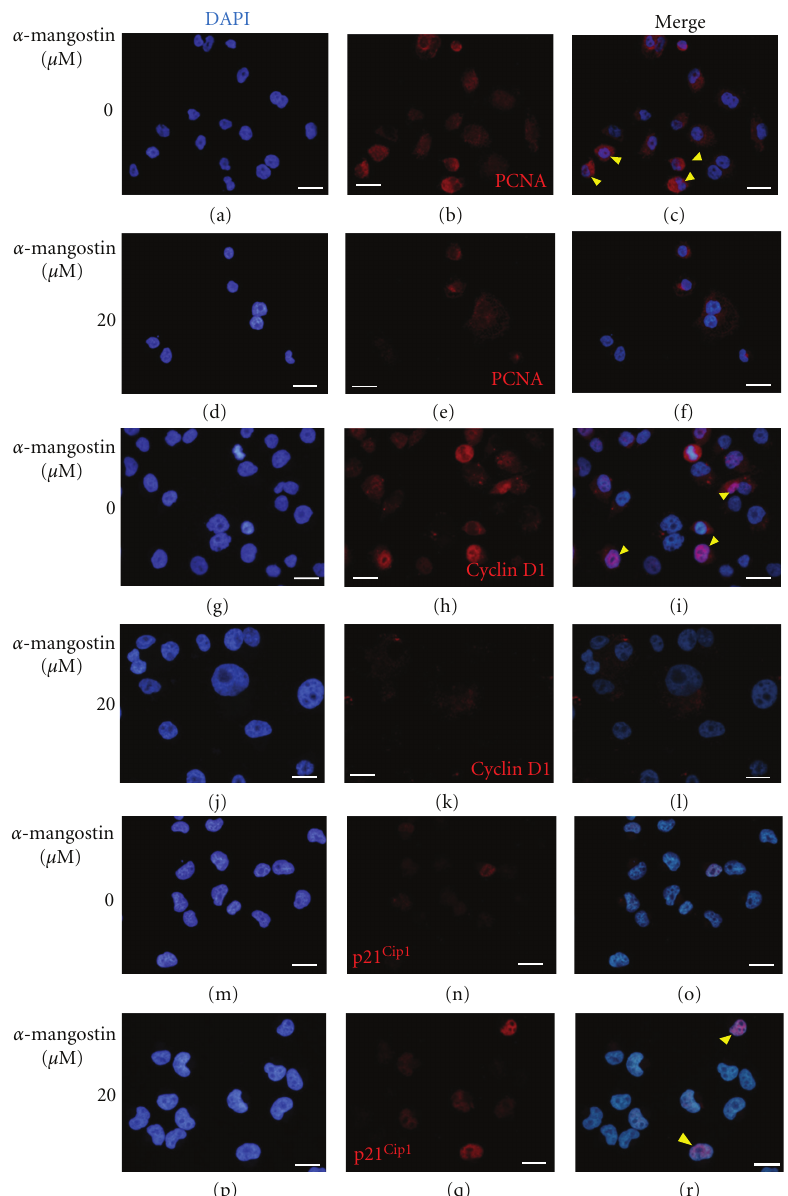
Figure 6: Expression of PCNA, cyclin D1 and p21 cip1 proteins after α -mangostin treatment. Immunofluorescence of PCNA (a)–(f), cyclin D1 (g)–(l), and p21 cip1 (m)–(r) in MDA-MB231 cells after 24 h of treatment with α -mangostin ((d)–(f), (j)–(l), (p)–(r)), as compared with controls ((a)–(c), (g)–(i), (m)–(o)). Yellow arrowheads in panels (c), (i), and (r) indicate higher expression of each protein in nuclei. PCNA and cyclin D1 expression was reduced and p21 cip1 expression were elevated in α -mangostin-treated cells, as compared to controls. Scale bars = 25 μ